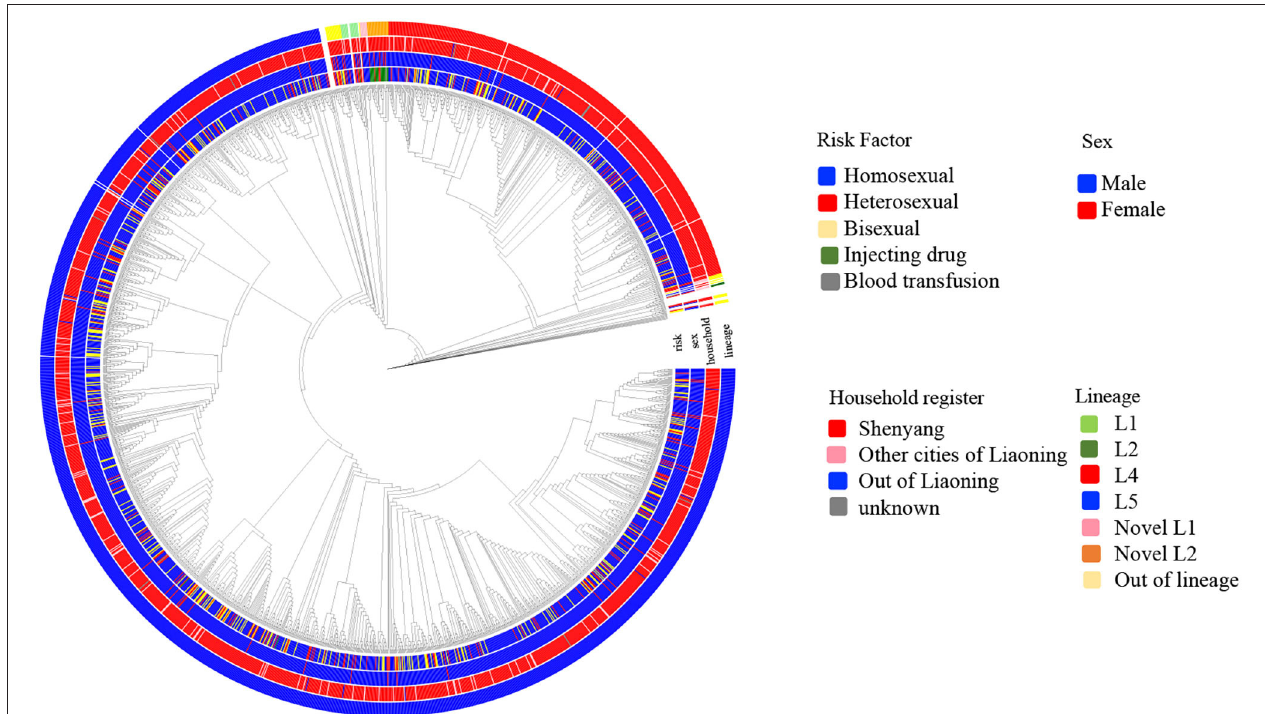
FIGURE 1 | The phylogenetic reconstruction of HIV-1 CRF01_AE in Shenyang during 2002–2017. The maximum likelihood tree was constructed using 2014 HIV-1 CRF01_AE pol sequences (HXB2:2253-3314 nt) sampled in Shenyang under GTR + I + G4 model with 1000 replicates in IQ-tree. The tree is rooted with three subtype A sequences as outgroup and the reference sequences (ref.5) were used to define CRF01_AE. Six lineages were identified, of which four were reported previously. Four colored circles represent risk factor, sex, household register and lineage from inner to outer.